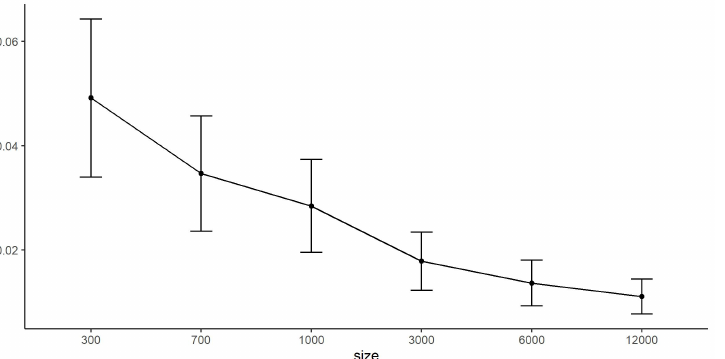
Figure 3. Relationship between D M and the size of the resampled data for M = 300, 700, 1000, 3000, 6000, and 12,000. The bars extend to one standard deviation above and below the average D M values from 500 simulation